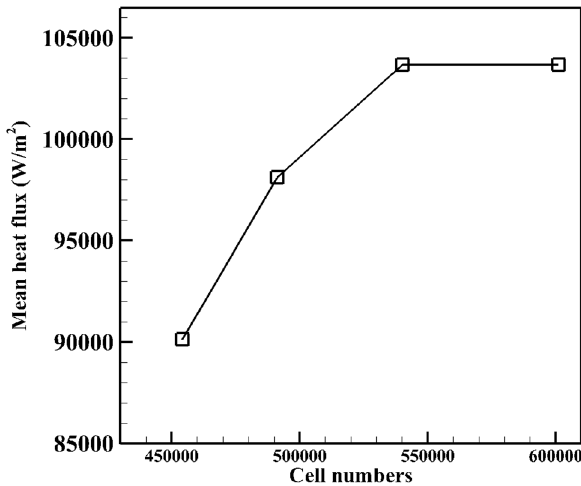
Fig. 8 Grid study for first step of simulation